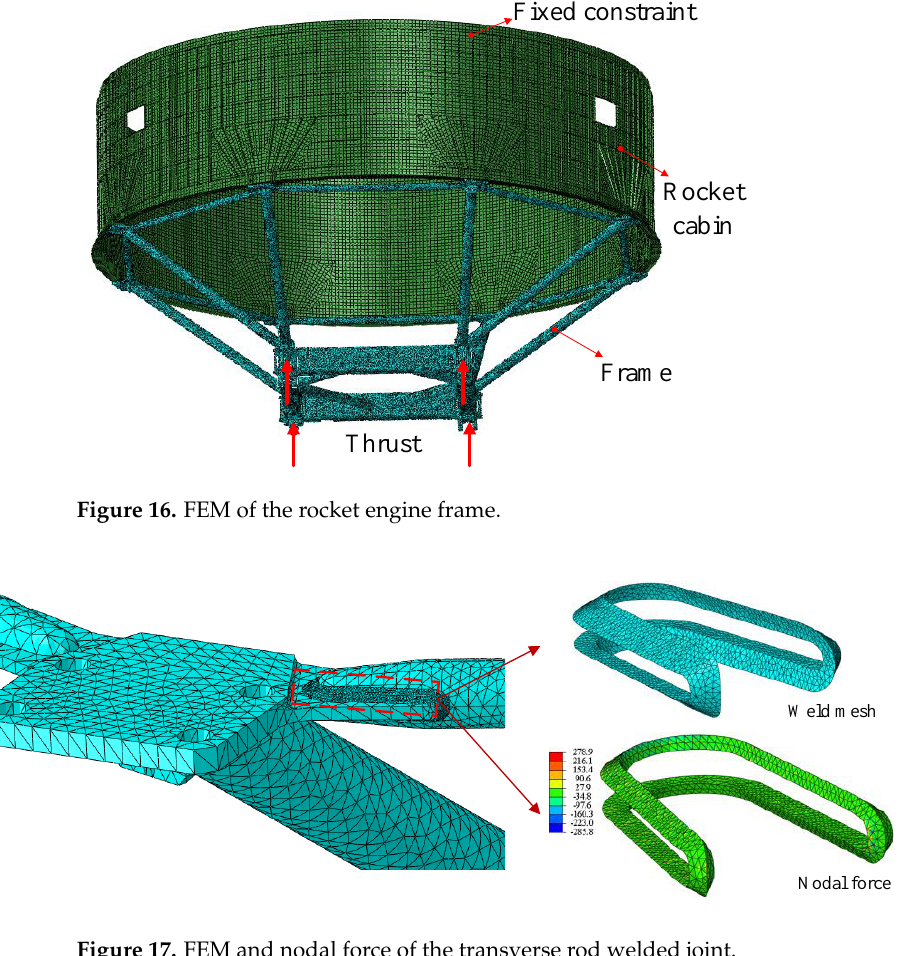
Figure 17. FEM and nodal force of the transverse rod welded joint.